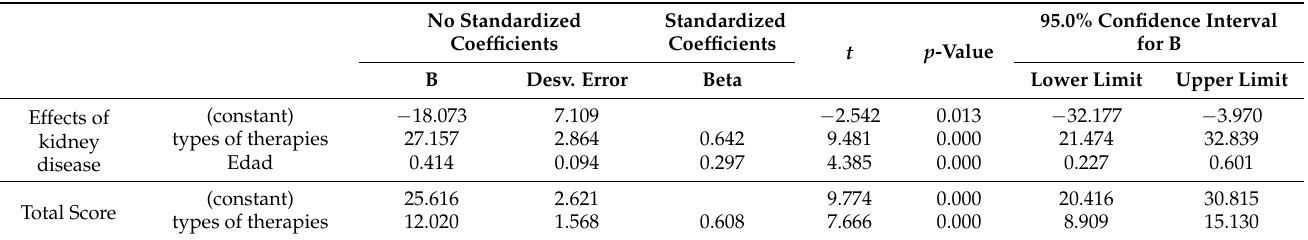
Table 6. Multivariate